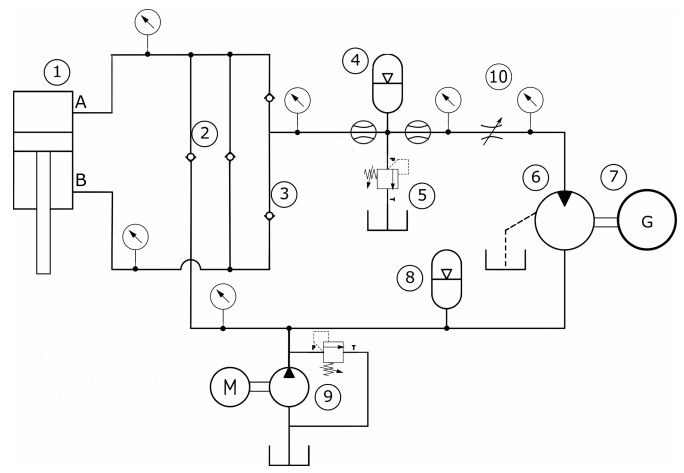
Figure 8. Experimental constant-pressure circuit.